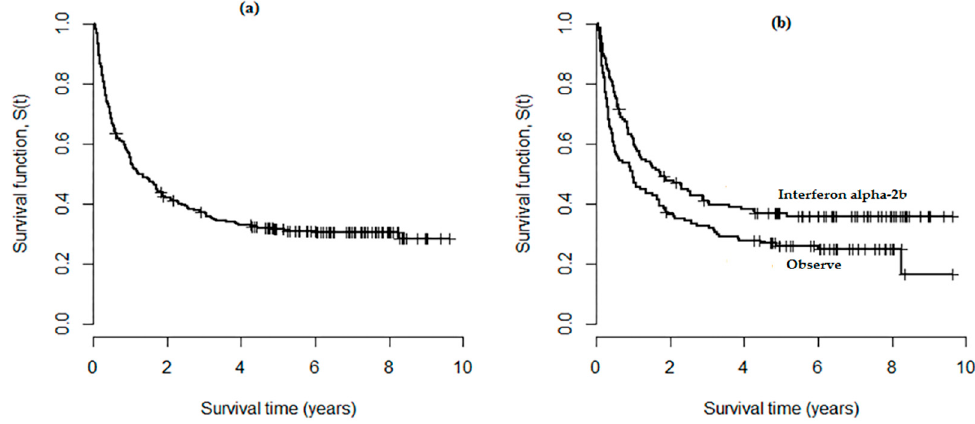
Figure 1. ( a ) Overall survival curve obtained by Kaplan–Meier approach for the e1684 data; ( b ) Survival curves for the two types of treatments.